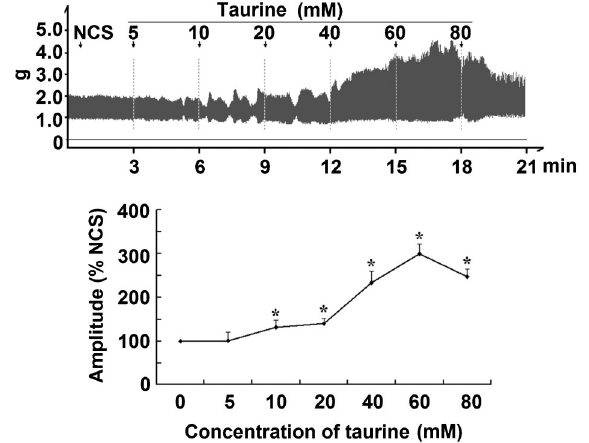
Figure 1. Effects of taurine on the contractile amplitude of isolated jejunal segments. Representative traces and statistical analysis (n=6) of taurine-induced effects on the contractile amplitude of isolated jejunal segments in the normal contractile state (NCS, control). The contractile amplitude in NCS is set to 100%; the effects of taurine on the contractile amplitude are the relative values compared with NCS. *P , 0.05 vs the contractile amplitude in NCS before taurine administration (one-way ANOVA).